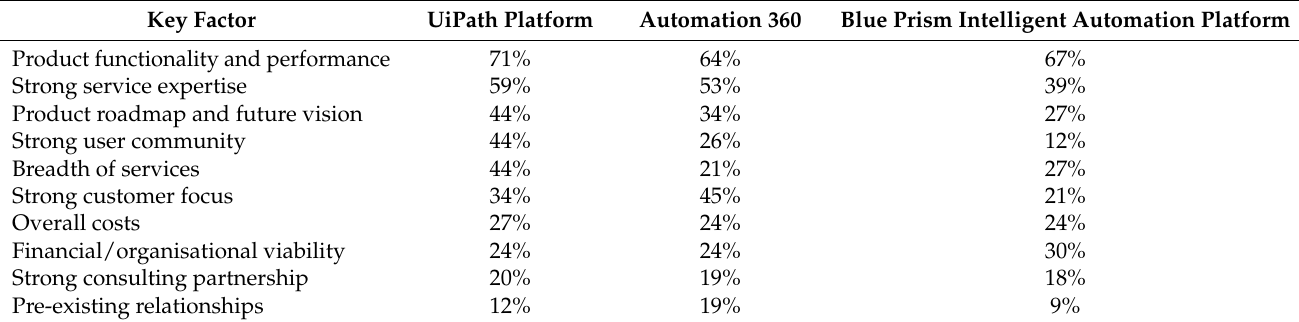
Table 5. Key factors leading to an automation platform’s